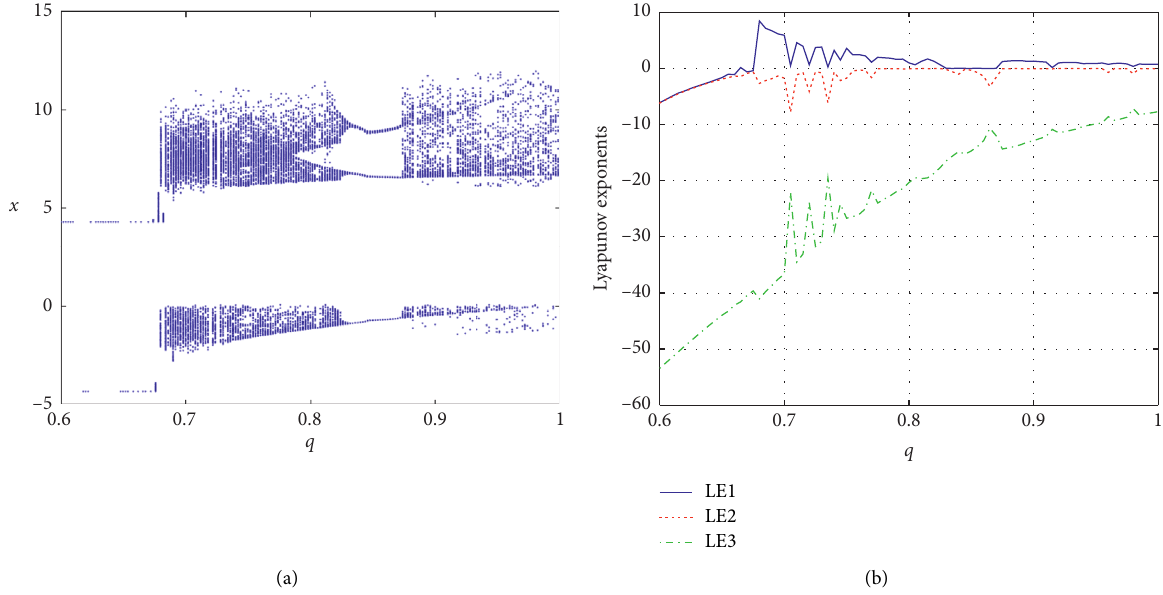
Figure 5: Bifurcation diagram and Lyapunov exponents spectrum of the fractional-order chaotic system (5) with initial conditional [ x z 0 ] � [1, 2, z 0 ]. (a) Bifurcation diagram. (b) Lyapunov exponents (LEs).